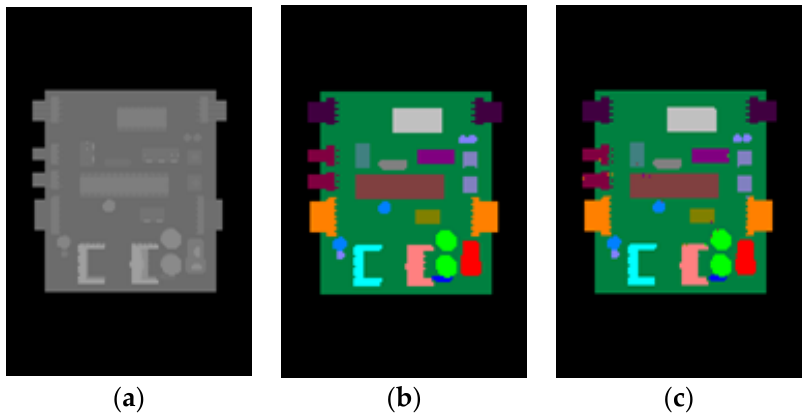
Figure 15. The results of our method for a controller board. ( a ) Synthetic depth image. ( b ) Color-labeled image. ( c ) The resulting pixel classification image of ( a ).